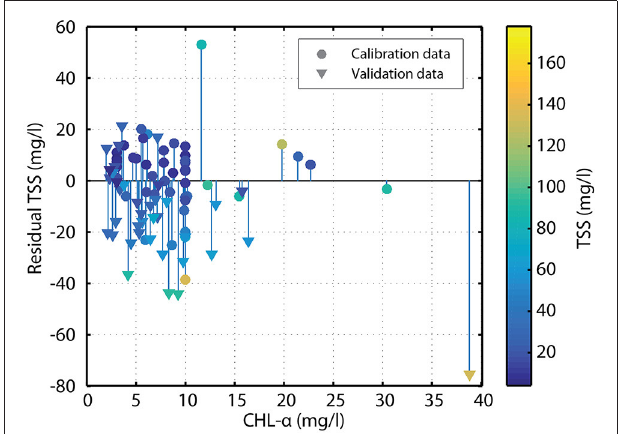
FIGURE 4 | Residual TSS from TSS model plotted against CHL-a sampled concurrently for both the calibration (triangles) and validation dataset (circles). Calibration and validation datasets are colored based on in situ TSS-values.